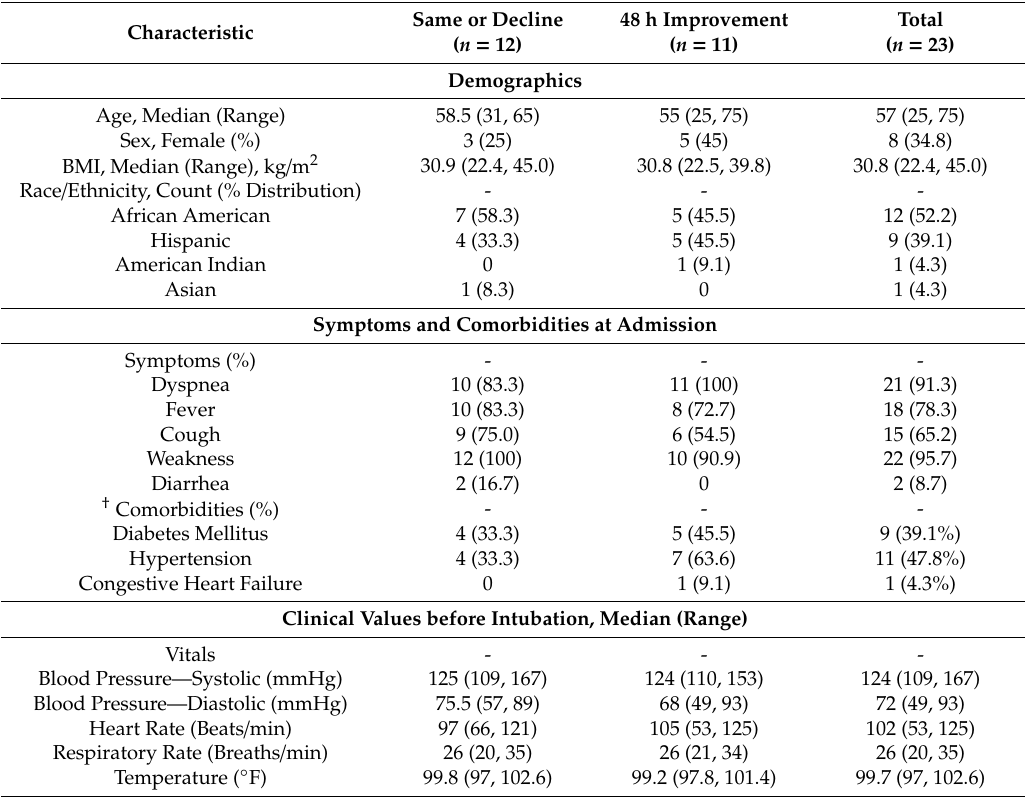
Table A2. Clinical characteristics, pronation timeline, and length of stay by 48 h improvement in PaO 2 / FiO 2